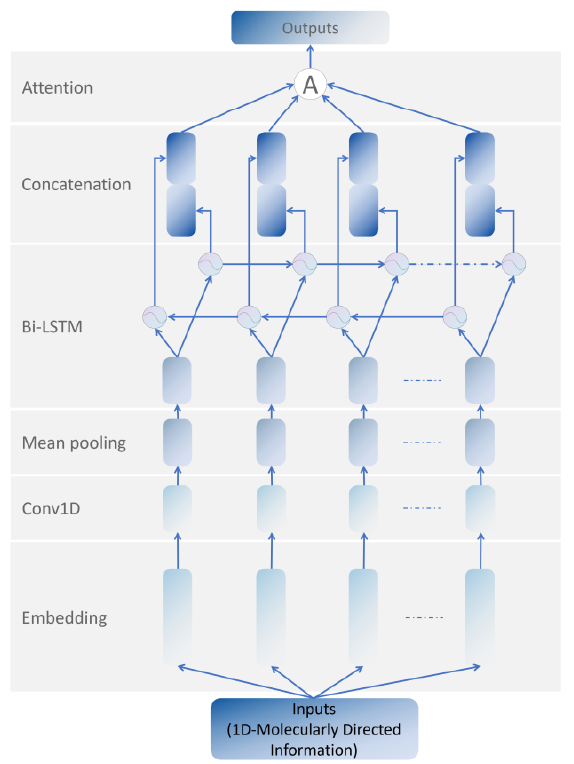
Figure 2. The 300 bit 1D Molecular Directed Information Feature Extraction Network.